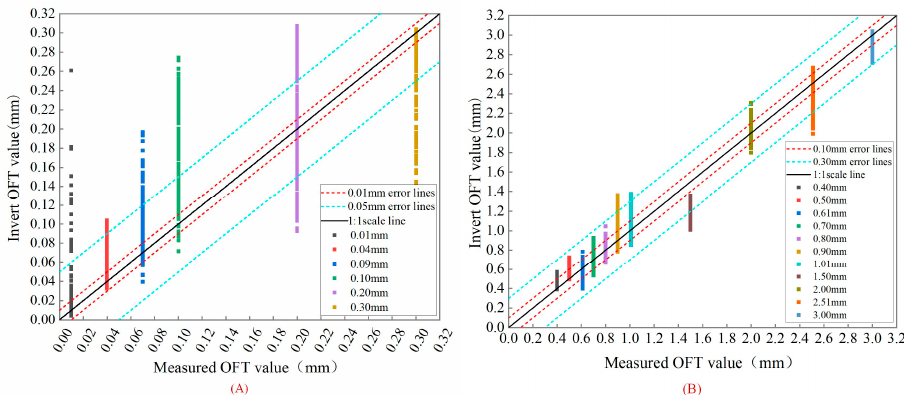
Figure 15. Comparison of measured OFT and inverted OFT at 20:00 on 2 August: ( A ) 0.01–0.30 mm; ( B ) 0.40–3.00 mm.